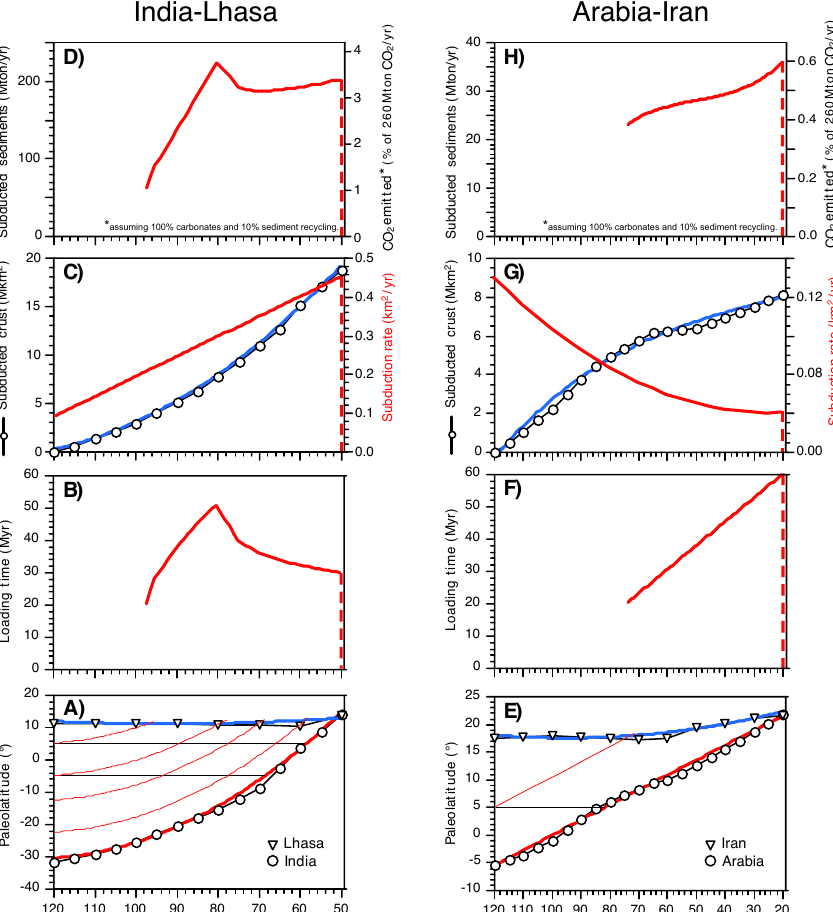
Fig. 4. Estimates of decarbonation in Tethyan subduction factory. Panels (A) – (D) refer to the subduction of Tethyan crust between Greater India and Lhasa (Asia). (A) Paleolatitude curves for northern Greater India (filled star in Fig. 3a) and southern Lhasa block (unfilled star in Fig. 3a) with 2nd order polynomial fits used to calculate the subduction time and the loading time of oceanic crust during passage through hypothesized equatorial upwelling belt (5 ◦ S–5 ◦ N). (B) Sediment loading time for passage through equatorial upwelling belt (5 ◦ S–5 ◦ N) of oceanic crust subducted under Asia. Curve starts at 97Ma with a nominal 20Myr loading time because the oceanic crust was sitting in the equatorial belt since appearance of pelagic carbonates and well before onset of subduction. (C) Amount of Tethyan crust as function of time between northern Greater India and southern Lhasa block that was eventually subducted under Asia plotted with a 2nd order polynomial fit resampled every 1Myr (blue line) and red curve showing subduction rate (scale on right) as 1st derivative of the polynomial subduction curve. (D) Amount of equatorial bulge sediments on Tethyan crust subducted under Asia per unit time as a function of geologic age. The axis on the right is the CO 2 emitted by these sediments expressed as percentage of the present-day global volcanic CO 2 emission rate of 260Mtyr − 1 , assuming the sediments were 100% carbonates and 10% recycled. Panels (E) – (H) refer to the subduction of Tethyan crust between Arabia and Iran (Asia) following the same procedure illustrated for India–Lhasa in panels (A) – (D) , with the only notable differences that the time scale extends to 20Ma and the paleolatitude curves – in (E) – are for the southeastern margin of Arabia (filled circle in Fig. 3a) and the western margin of the Iran block (unfilled circle in Fig.